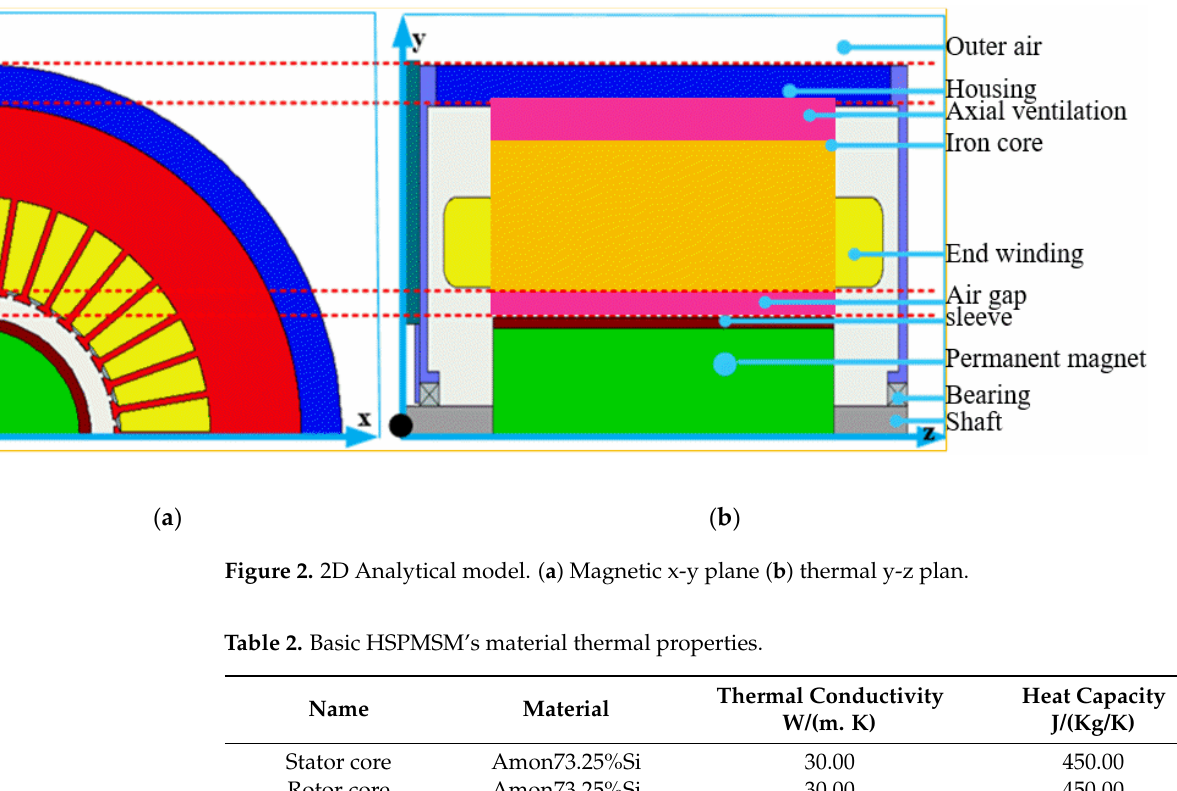
Table 2. Basic HSPMSM ′ s material thermal properties.